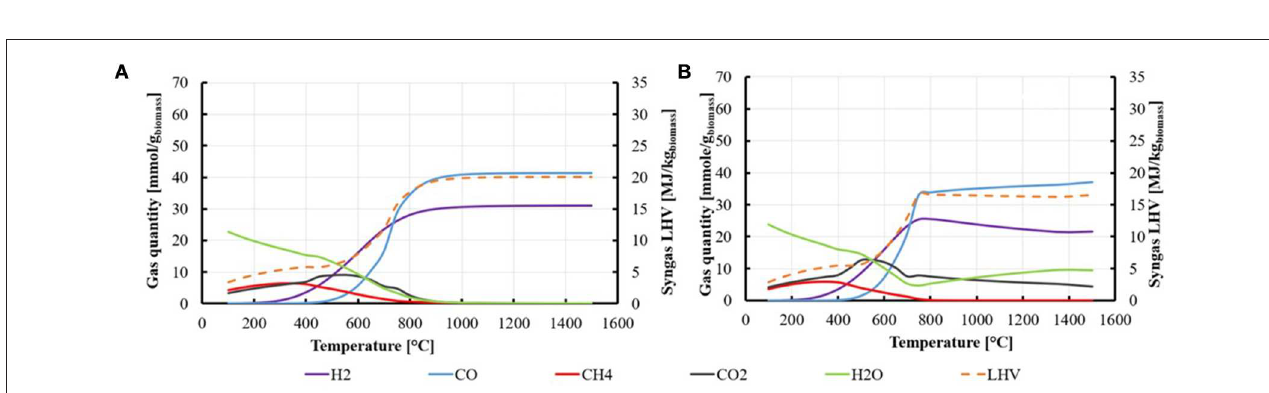
significant. Figure 4 plots the quantities of iron species (Fe 2 O 3 , Fe 3 O 4 , FeO, Fe) obtained at thermodynamic equilibrium for stoichiometric gasification conditions over iron oxide.